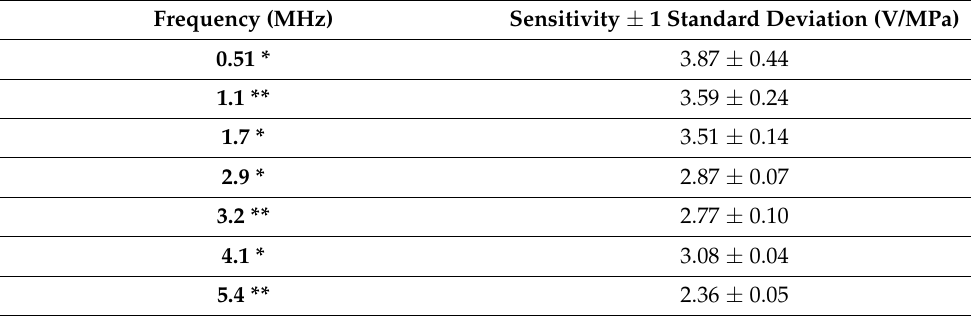
Table 2. PVDF receiver sensitivity with corrected preamplifier